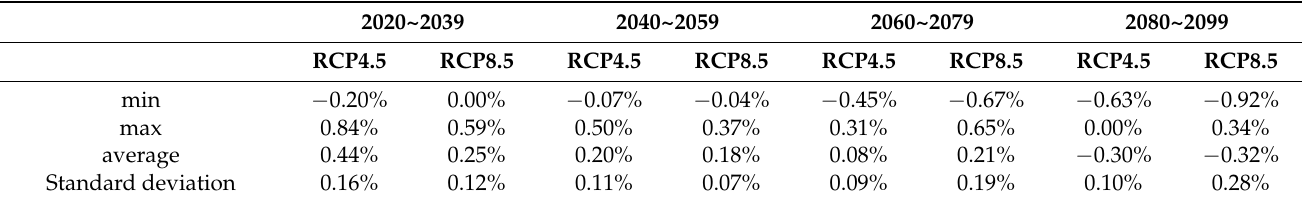
Table 2. Quantitative assessment of future wave climate change results around